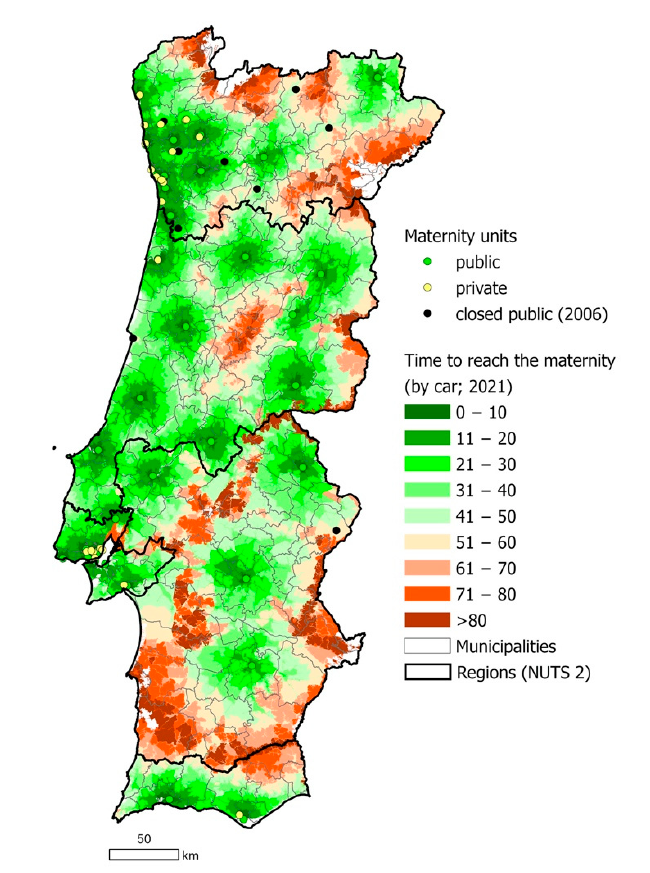
Figure 3. Map showing travel time by car to reach the nearest maternity unit, municipality boundaries, and locations of running and closed (in 2006) public maternity units and running private maternity units, in Portugal in 2021. Source: based on data retrieved from ESRI, the NHS portal [24] and the Birth Advisor portal [25].